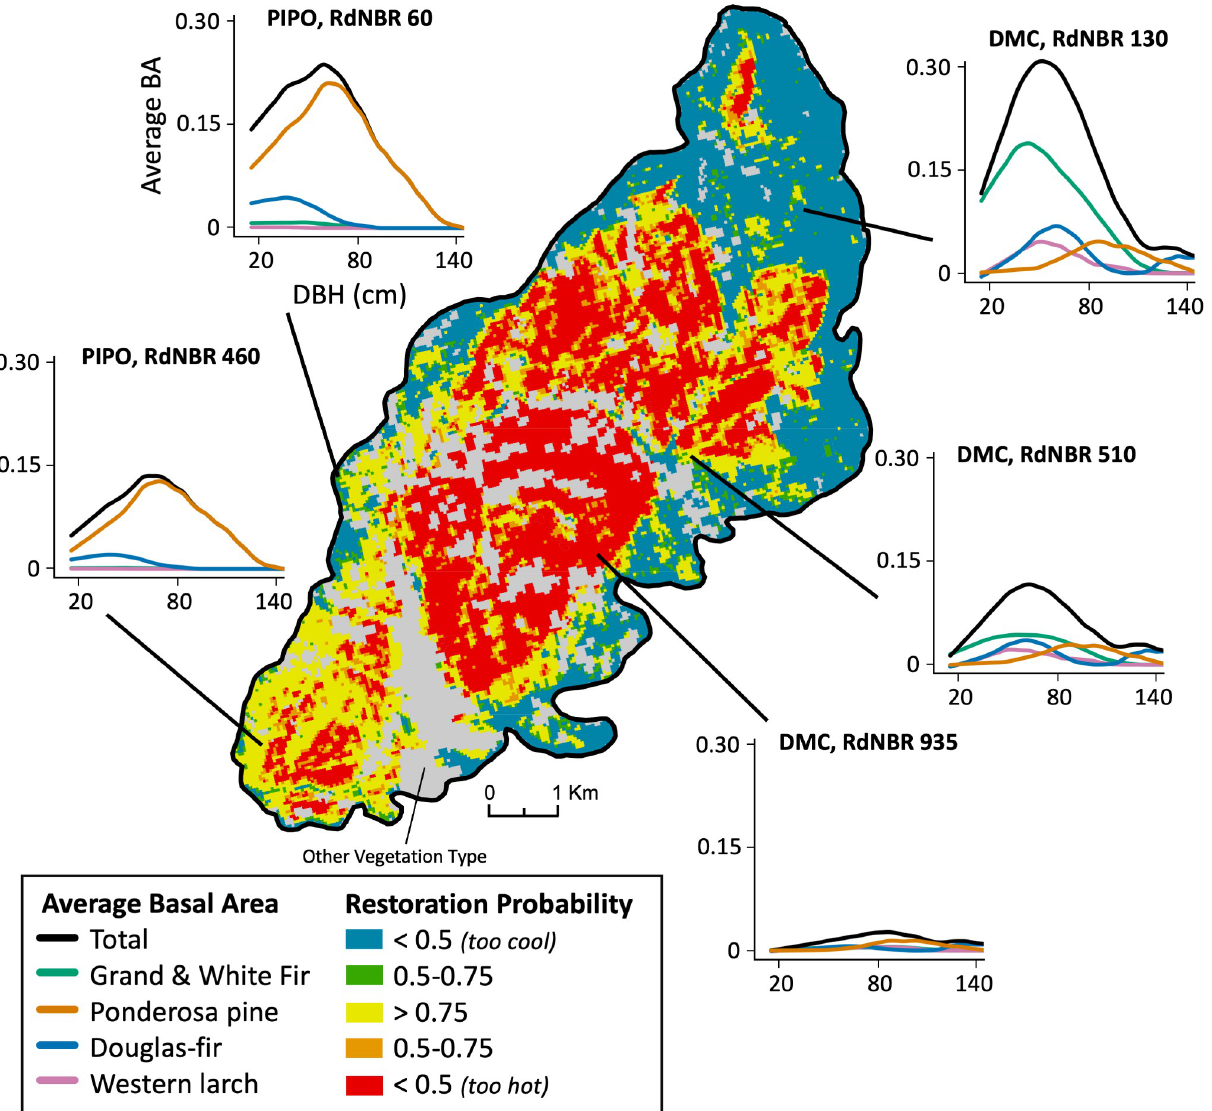
Fig 7. RdNBR fire severity for the 2012 Parish Cabin fire on the Malheur National Forest reclassified according to the probability of restoring stand basal area. Cool colors represent pixels with RdNBR values below the severity range with the highest restoration probability and warm colors represent pixels with RdNBR values above this range. Graphs display model estimated average basal area distribution within a 1 ha stand, by tree diameter for all trees � 15 cm and major species at select RdNBR burn severities observed on the map for ponderosa pine (PIPO, left) and dry mixed conifer (DMC, right) forest types. Grey areas on map indicate other vegetation